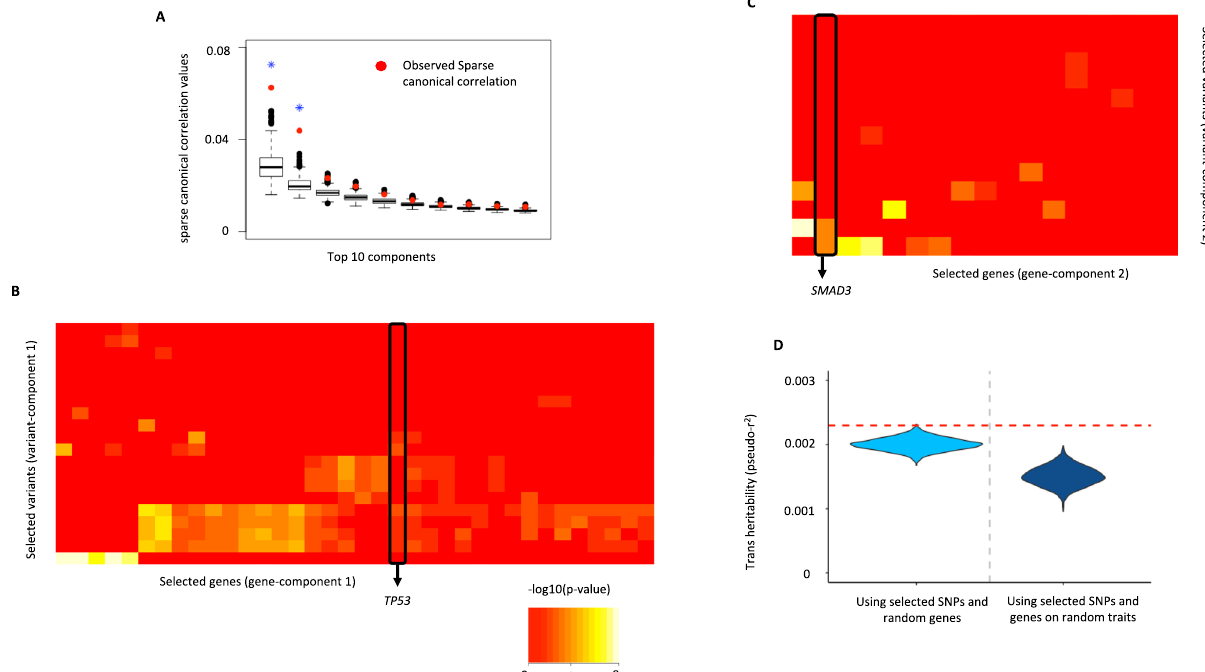
Fig. 5 Analysis of selected target gene-set for Prostate Cancer (PC). A Top 10 cc-values (red) and the corresponding competitive null distributions (black box plot) for ARCHIE analysis of PC. Top 2 ARCHIE components are signi fi cant. The box plot for competitive null distribution is presented as ±1.5 interquartile range with the median line denoted at the center. The competitive null distribution denotes the general pattern of sparse canonical correlation (and trans-associations) expected in analysis of variants that are not speci fi c to PC. The signi fi cant ARCHIE components are marked by a blue asterisk. -log 10 p-value for trans-eQTL association between variants and genes selected in B ARCHIE component 1 and C component 2 as reported in eQTLGen data. TP53 and SMAD3 are highlighted. Any association p value < 10 − 08 is collapsed to 10 − 08 for the ease of viewing. D trans-heritability enrichment analysis for target genes selected for PC. The violin plots represent the distribution of pseudo-r 2 for the selected SNPs and a random gene-set of the same size on PC (left) and the distribution of pseudo-r 2 of the selected genes and SNPs on a random trait in UK Biobank (right). The red dashed line represents the observed pseudo-r 2 for the selected SNPs and target genes for PC (See Results and Methods for